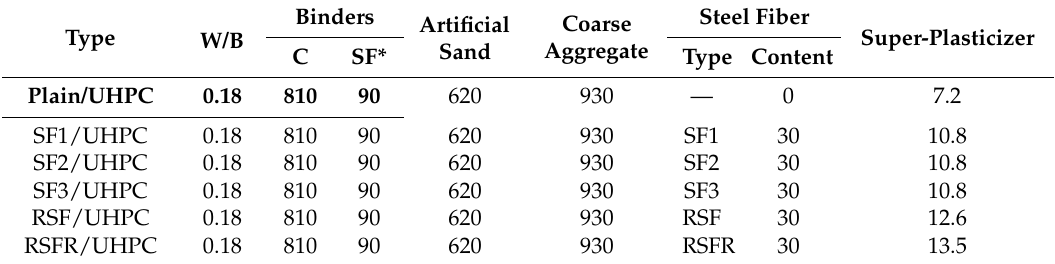
Table 2. Mix proportions of ultra-high performance concrete (UHPC) (kg/m 3